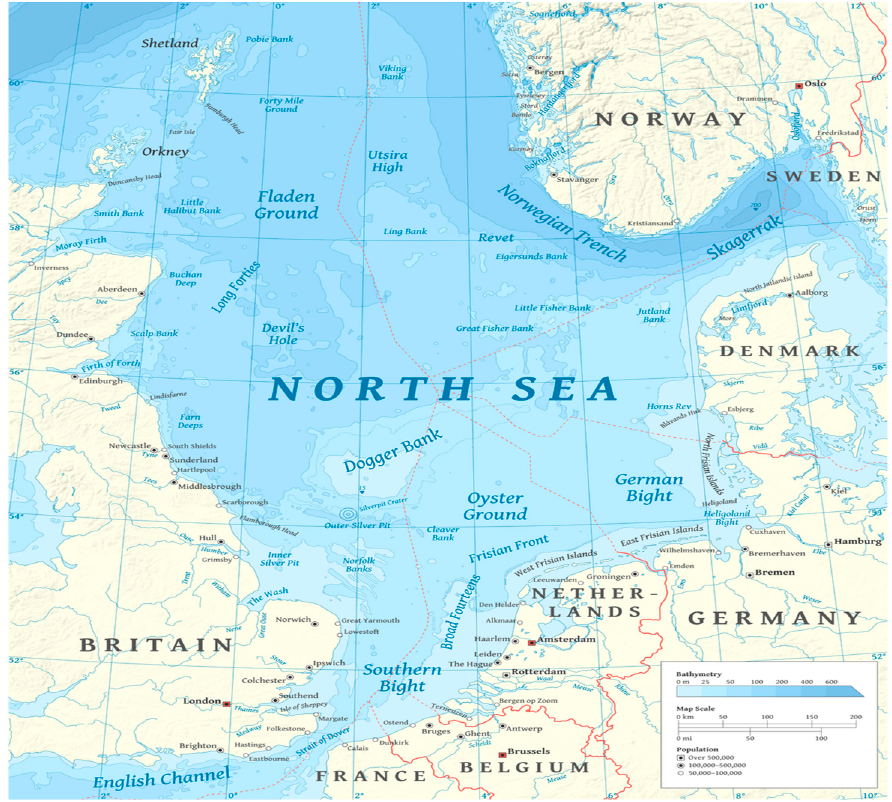
Figure 1. Map of the North Sea [2], with permission from Halava, CC BY-SA 3.0, via Wikimedia Commons.